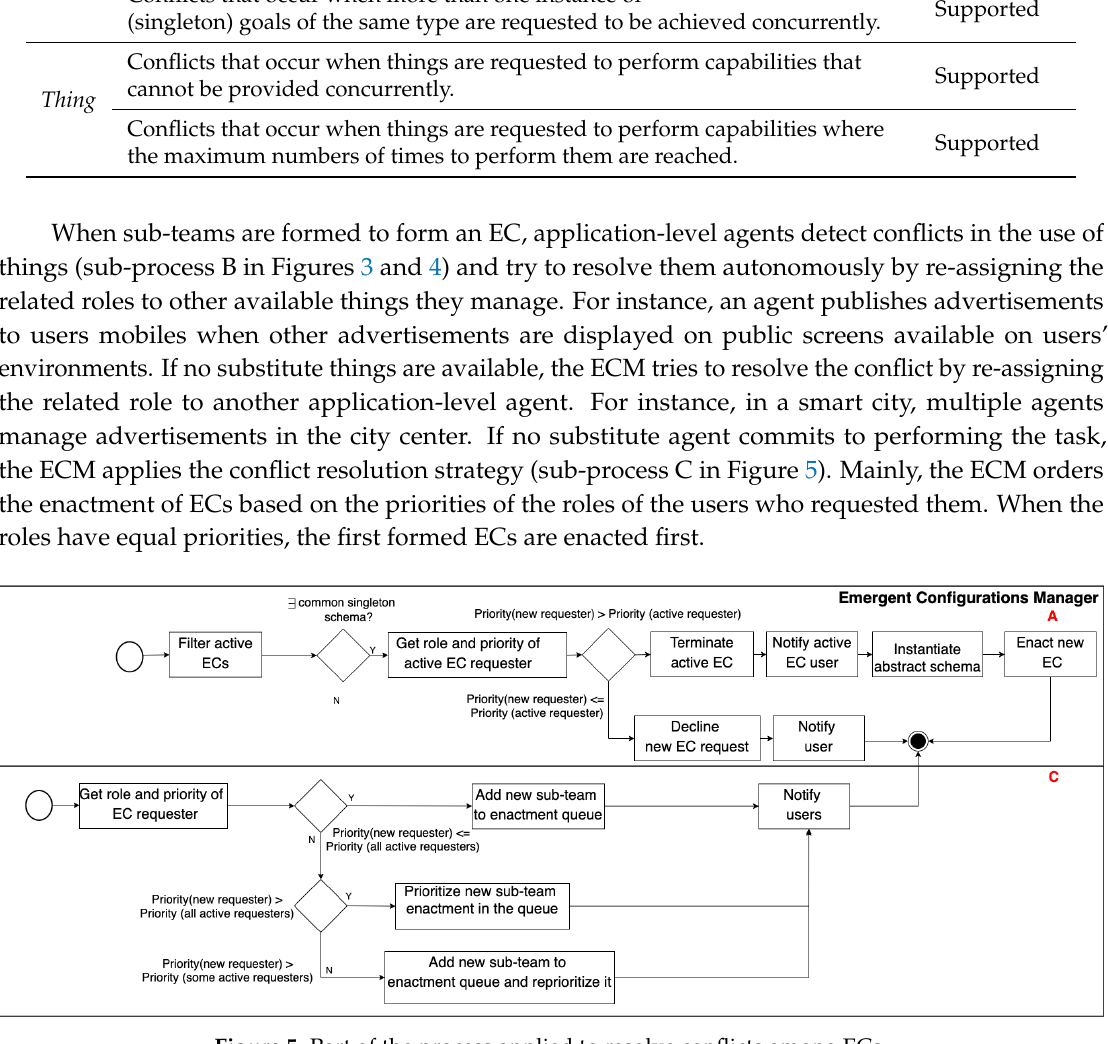
Figure 5. Part of the process applied to resolve conflicts among